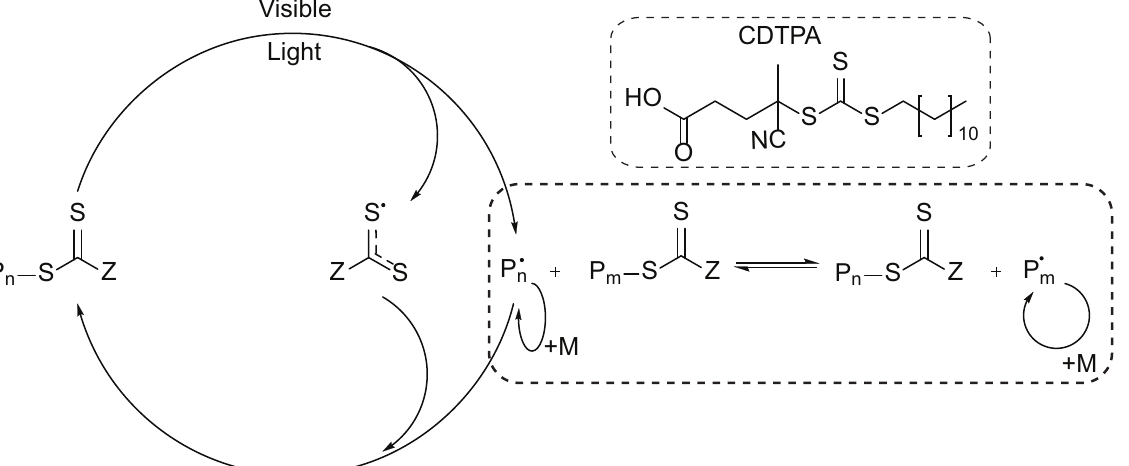
Figure 3. Mechanism of photoiniferter polymerization under visible light.